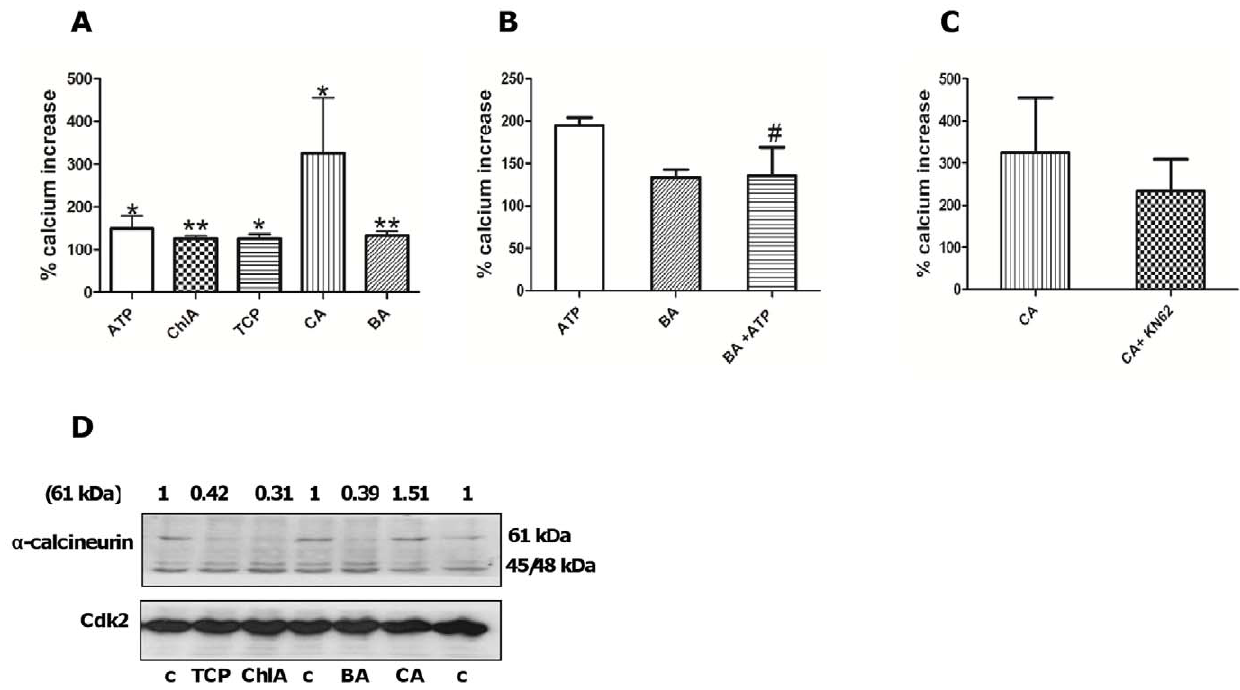
Figure 2. Male-specific pancreatic carcinogens increase Ca 2 + levels and activate a -calcineurin. ( A ) Fura-2-loaded Panc-1 cells were treated with ATP (200 m M), ChlA (100 m M), TCP (1 mM), CA (50 m M) or BA (500 m M). *significantly different from controls (set to 100%) (*p , 0.05, **p , 0.01). ( B ) BA + ATP-treated cells were pretreated with BA and thereafter with ATP. # significantly different from ATP, p , 0.05. ( C ) Cells were preincubated with KN62 (100 nM) for 10 min followed by CA (50 m M) treatment. ( D ) Cells were treated with chemicals (10 m M) for 15 min. Levels of a -calcineurin (45/48 kDa, active form and 61 kDa, inactive form) were analyzed by Western blotting. Three different controls (c) were used. In A, B and C results are presented as mean 6 SD,